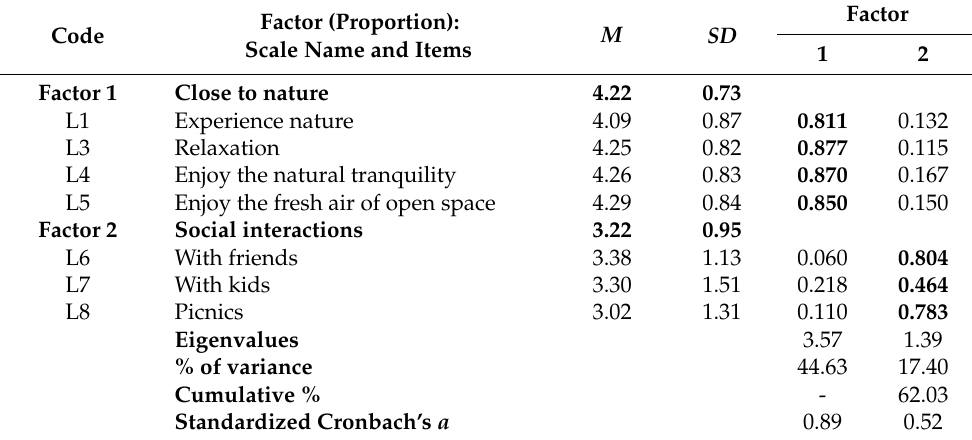
Table A3. Summary results of exploratory factor analysis for leisure motivations ( n = 595, 2021